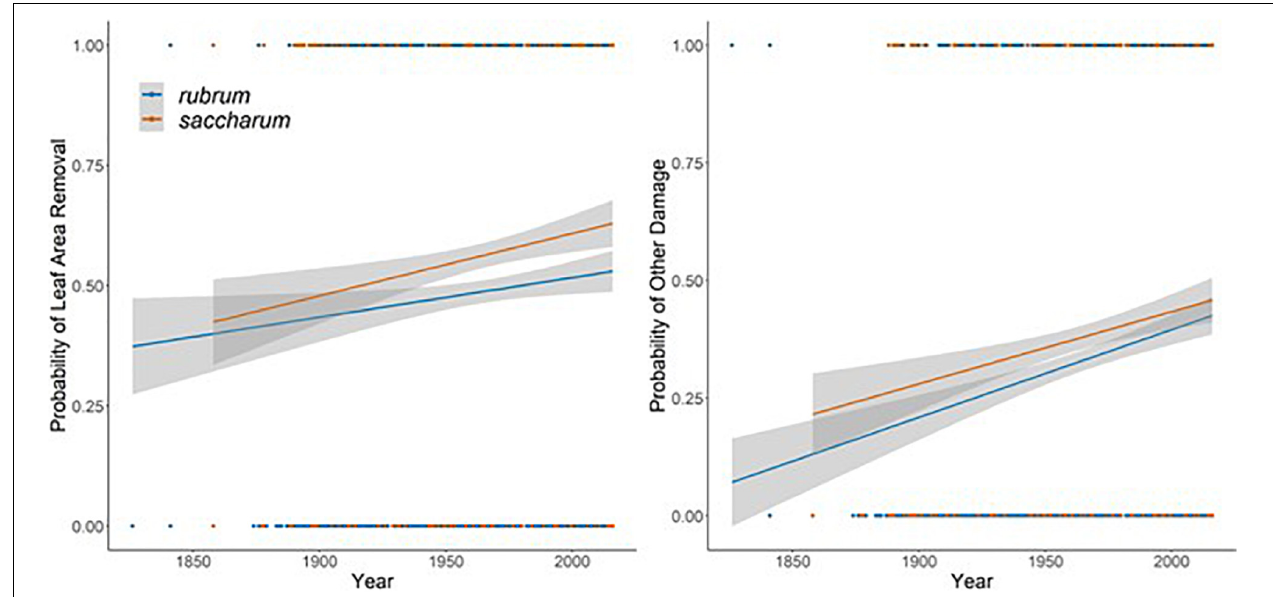
FIGURE 7 | The probability of a specimen showing evidence of leaf area removal (left) and other damage (right) by year of collection. Lines are best fit logistic regressions with shaded areas indicating the 95% confidence interval and fit independently to each